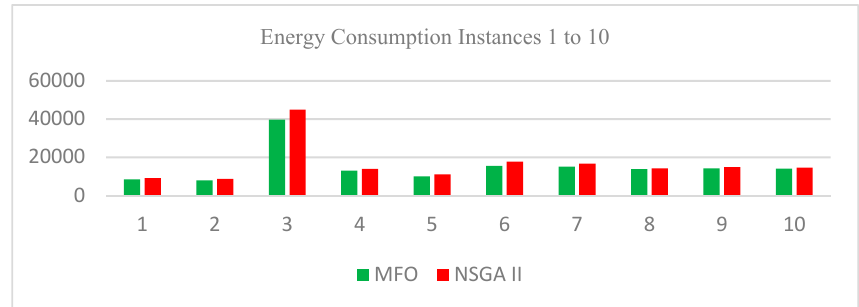
Figure 14. Energy consumption values of all instances 1–10.